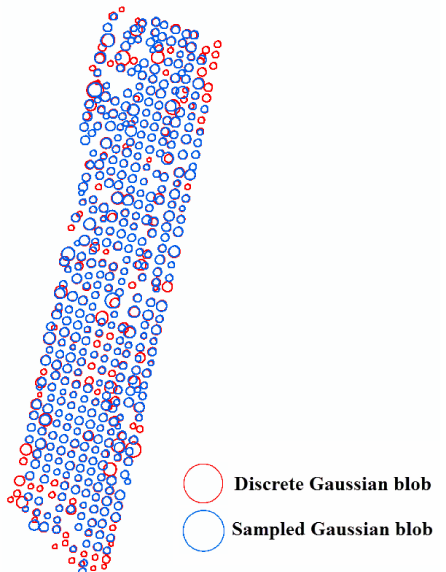
Figure 10. Di ff erences between sampled and discrete Gaussian scale-space blob detection for the walnut